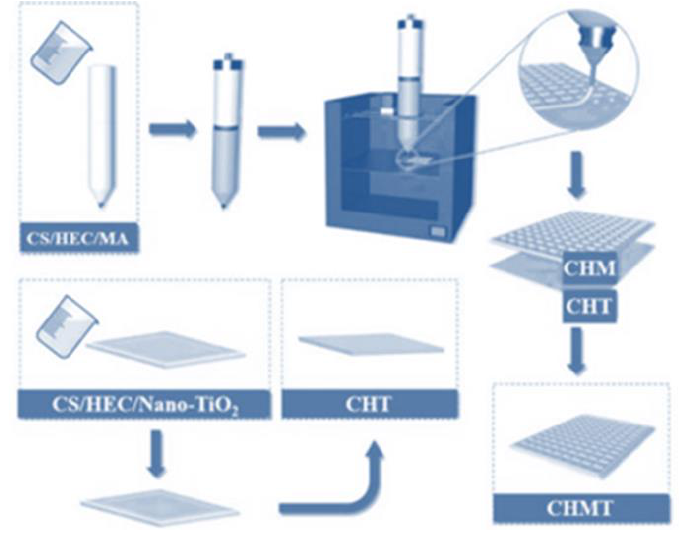
Figure 1. Preparation process of the 3D-printed bilayer films.